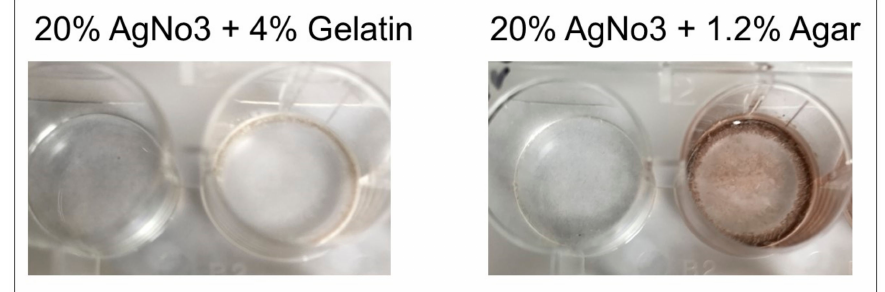
Figure 8. Matrix bed development with 6% gelatin or 1.2% agar. Left image: 6% gelatin was mixed with 20% silver nitrate and added to wells, followed by polymerization solution (0.5 mL); right image: 1.2% agar was mixed with 20% silver nitrate and added to wells, followed by polymerization solution (0.5 mL). Upon development of the agar matrix, a color was produced, and therefore gelatin matrices will be preferentially developed for colorimetric reaction.